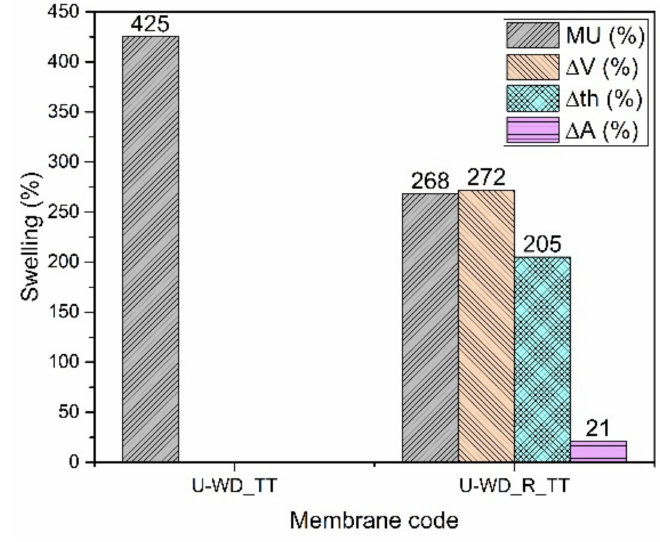
Figure 7. Swelling data of U-WD membranes. 3.2.5. Blend Membranes of 70% SPEEK and 30% SPPSU Cast from Mixture 90% Water and